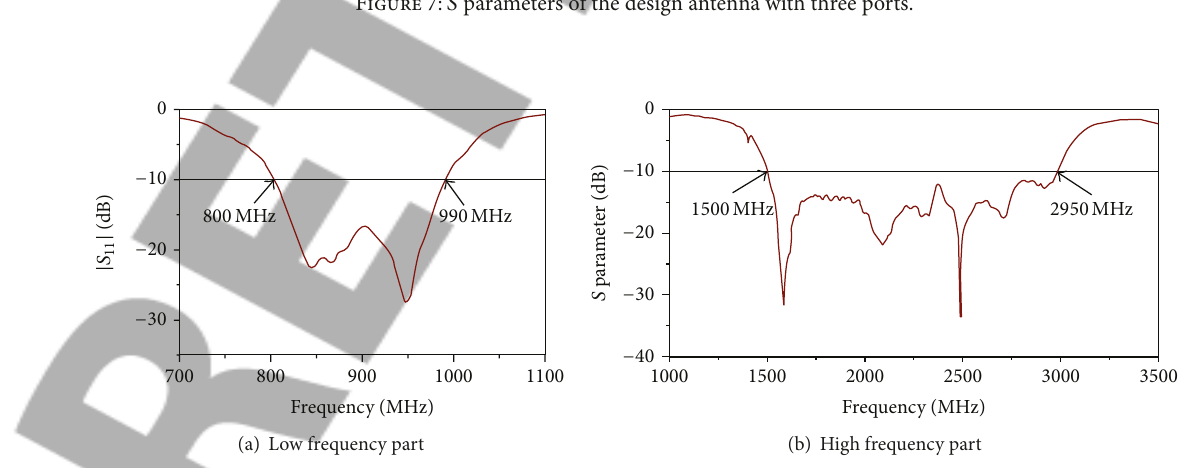
Figure 7: 𝑆 parameters of the design antenna with three ports.